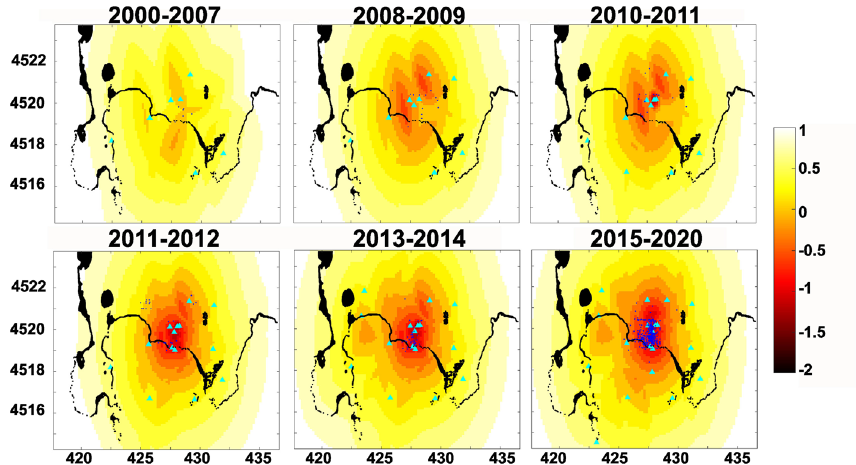
Figure 2. Temporal variations of the sensibility to location of the seismic network. Seismic stations are indicated by cyan triangles and earthquakes with Md ≤ 0.2 are shown by blue dots. The colorbar indicates the magnitude threshold of location. Map coordinates are km